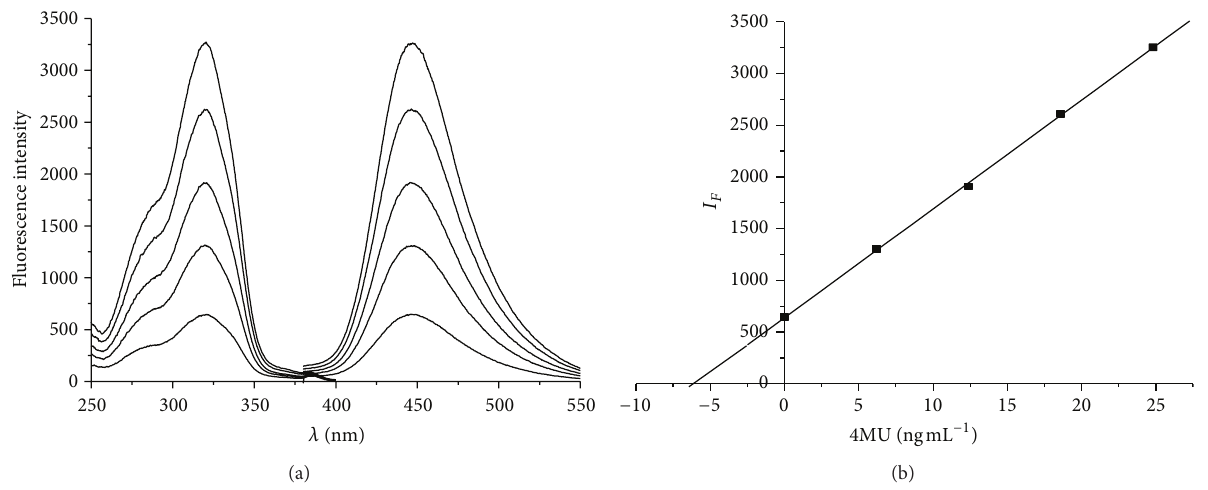
Figure 8: (a) Fluorescence spectra and (b) plot of fluorescence intensity versus concentration of a standard addition method for the determination of 4MU in CDC sample. pH: 5.98; 𝜆